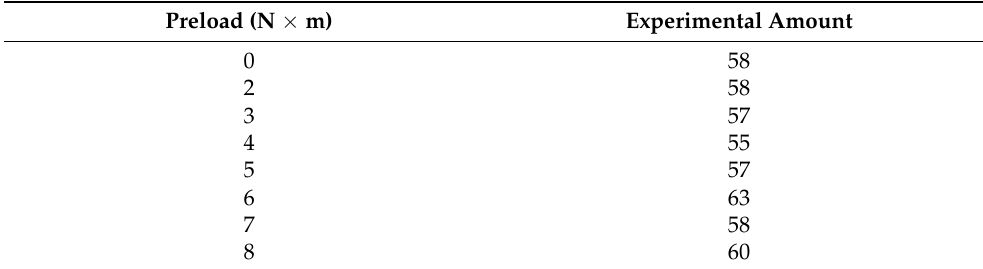
Table 2. Data distribution with the time-reversal method.